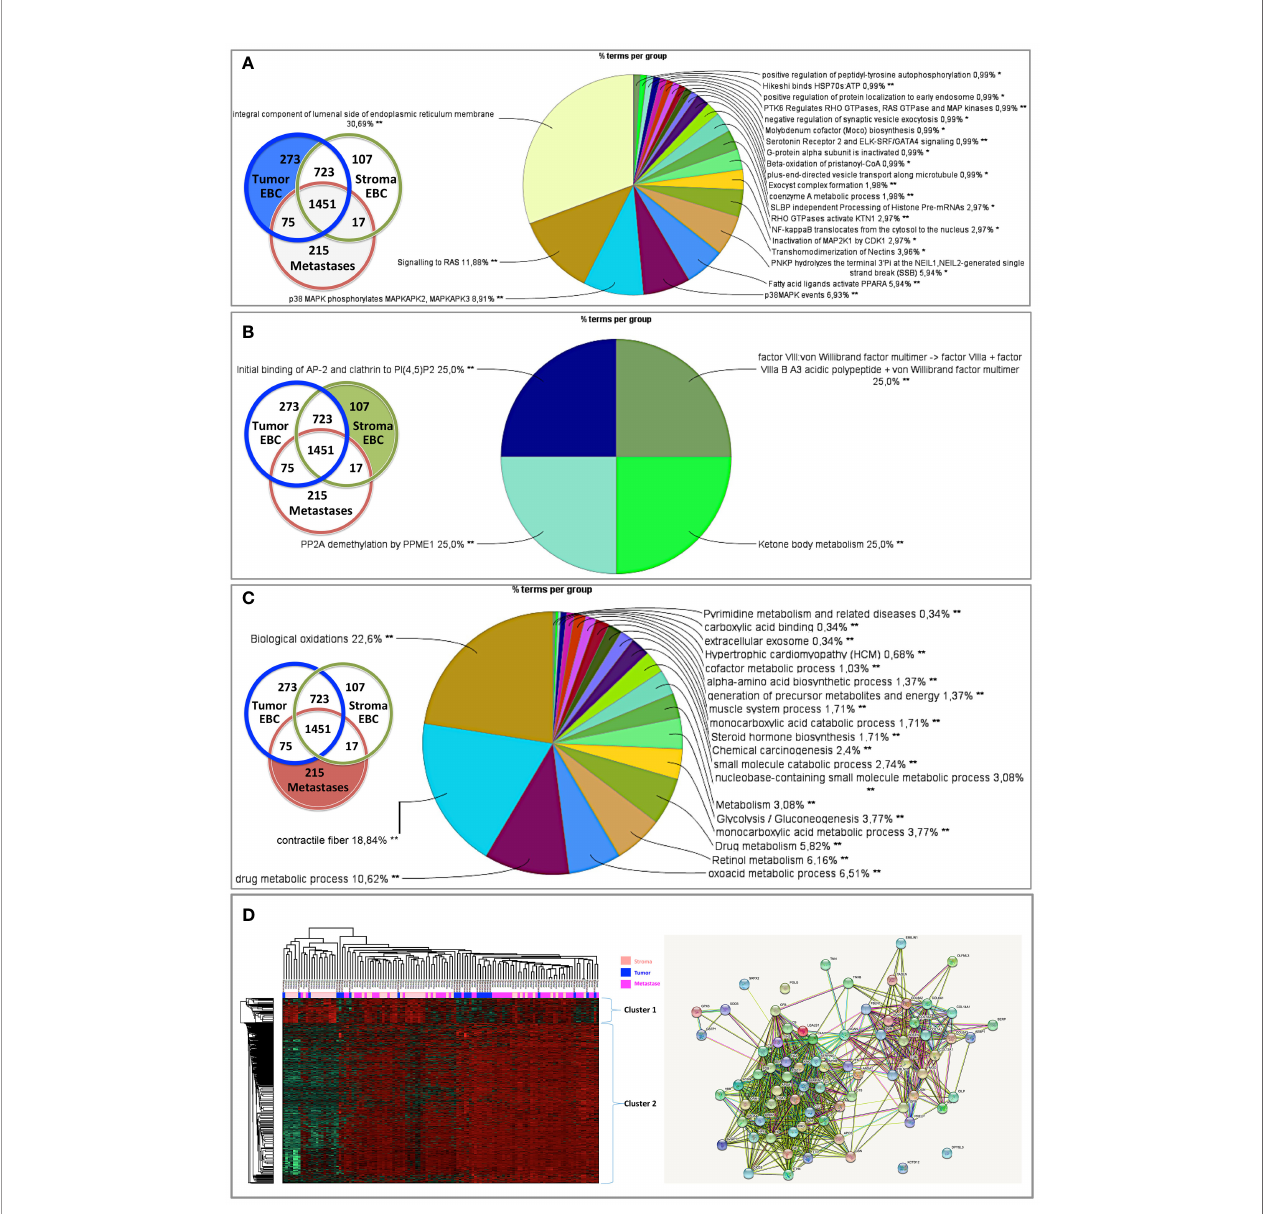
FIGURE 6 | Biological processes enriched from proteins speci fi cally found in (A) primary tumors, (B) stroma, or (C) metastases. Proteins differentially expressed in (D) primary tumors, stroma and metastases were analyzed using a multiple sample test ANOVA with a p<0.01 and represented in a heat map (on the left) identifying 2 clusters separating the stroma (Cluster 1) from the primary tumor and the metastases (Cluster 2). The String networks of the clusters are shown on the bottom right Analyses were performed with Cytoscape, ClueGo and String; proportions of processes in %. *p<0.05;